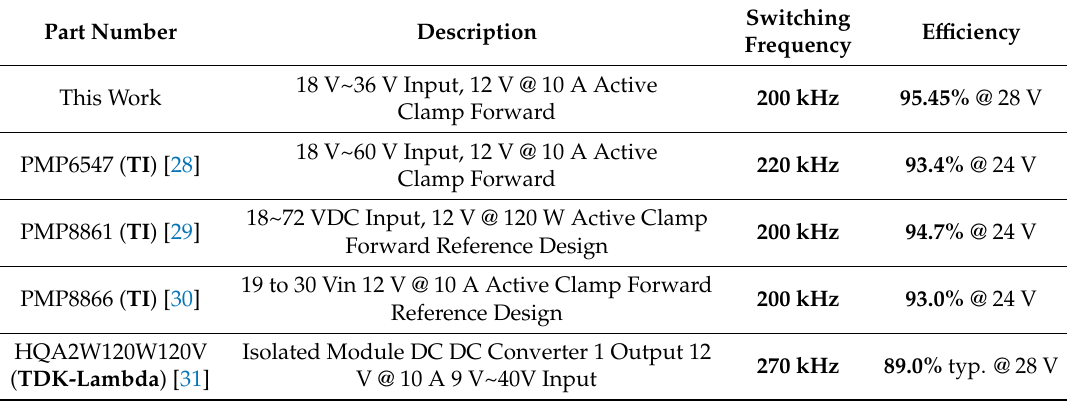
Table 5. The e ffi ciency of the Investigated DC-DC Converters at Full